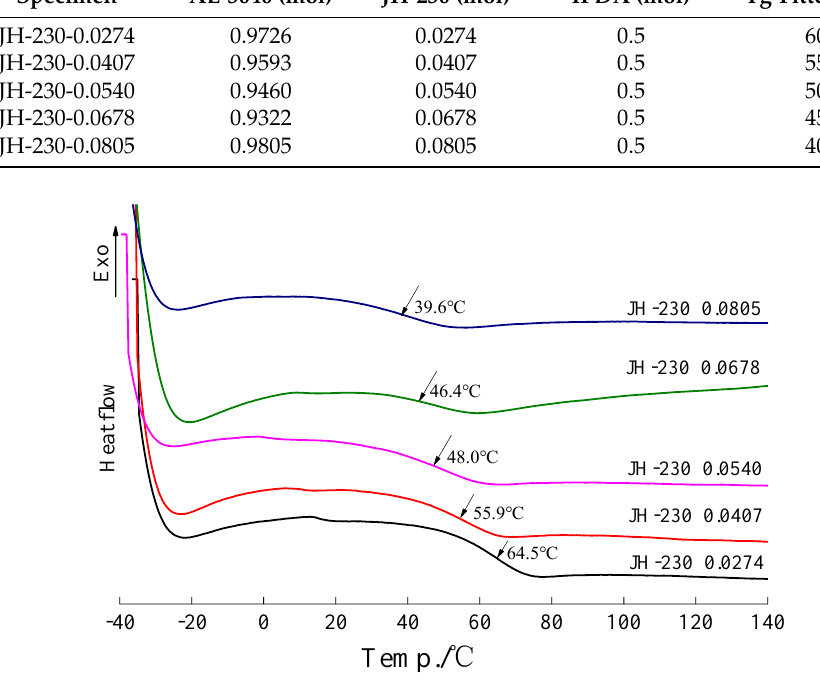
Figure 5. The second heating differential scanning calorimeter (DSC) curves of the shape-memory hydrogenated epoxy resin with inverse calculated formulations (heating flow = 10 °C/min).